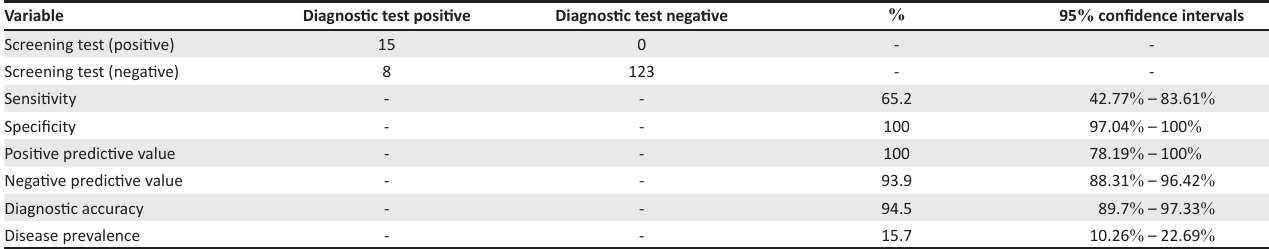
TABLE 1: Outcome of screening and diagnostic tests.